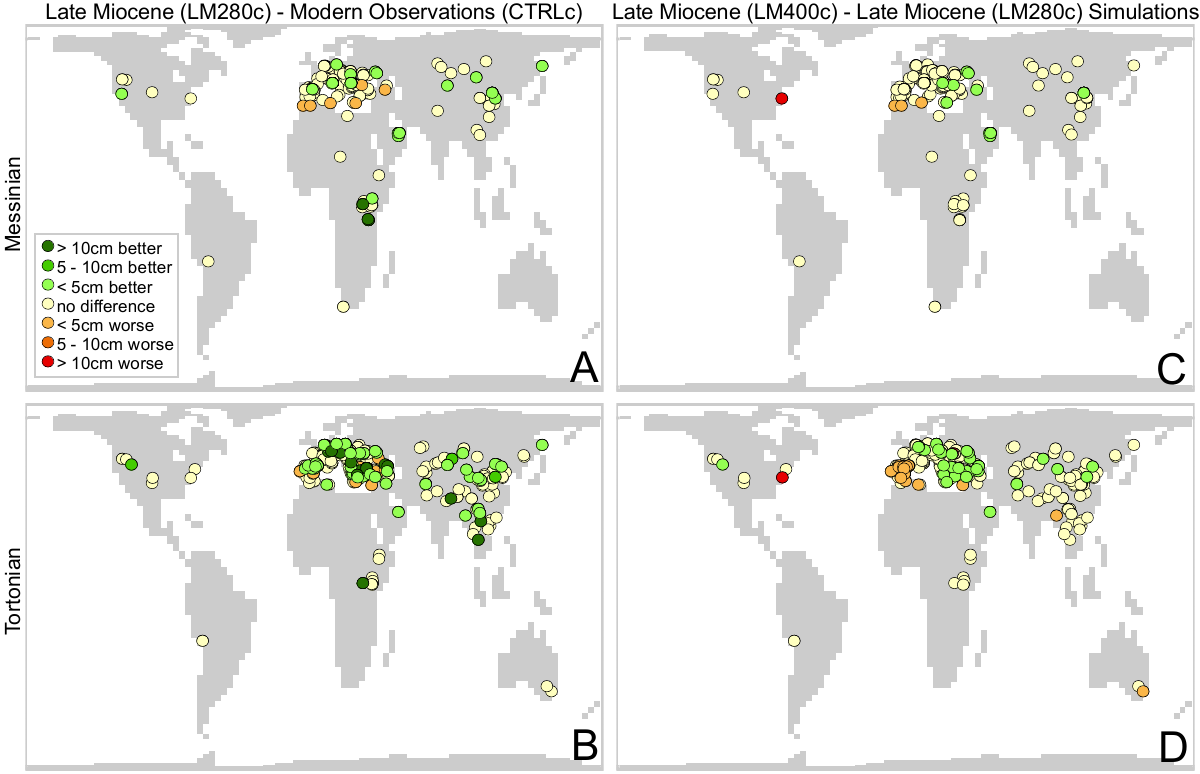
Fig. 14. Improvements in the model–data comparison for mean annual precipitation. The lefthand column (A, B) shows the improvement that the late Miocene palaeogeography makes to the model–data comparison. The righthand column (C, D) shows the improvement that higher CO 2 makes to the model–data comparison. Green circles indicate an improvement; red circles indicate a deterioration. The datapoints showing “no difference” (white circles) are plotted underneath the other datapoints in order to highlight the